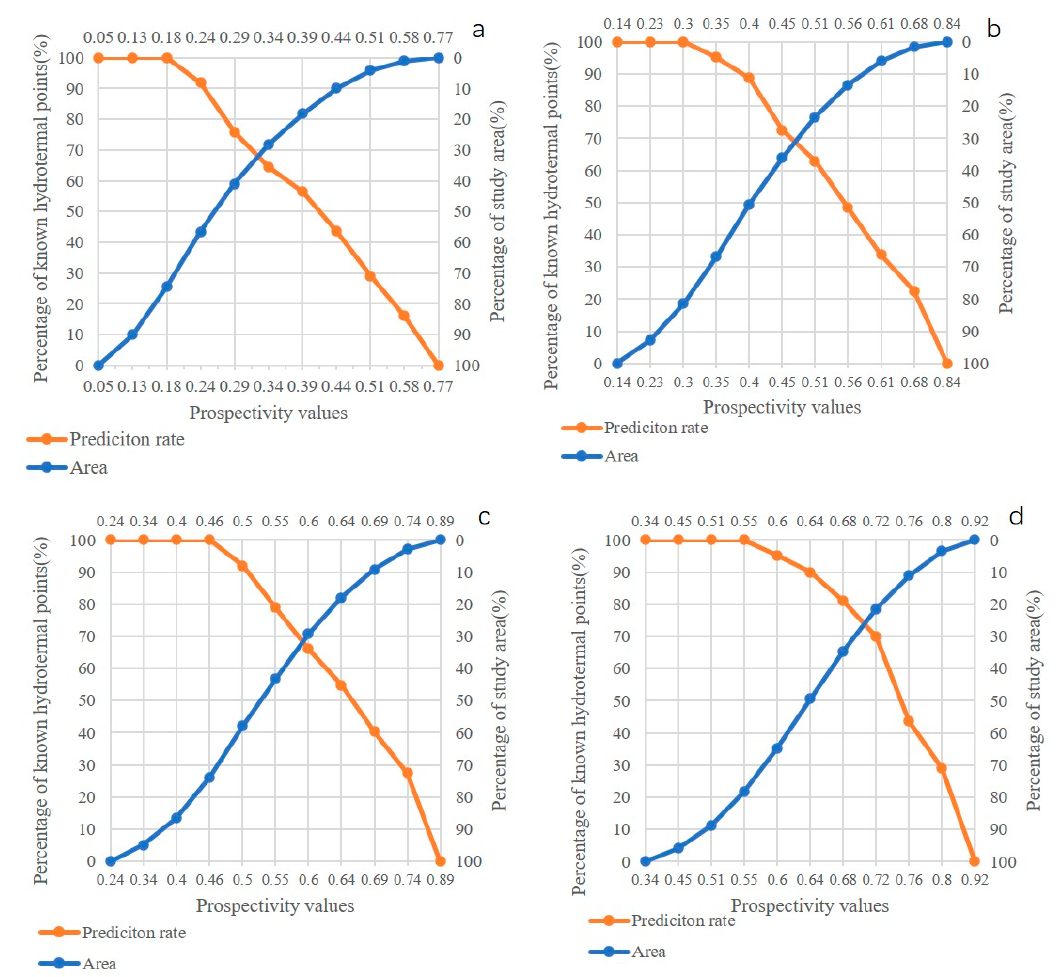
Figure 5. Comparison of di ff erent gamma values in fuzzy logic model. ( a ) γ = 0.85, ( b ) γ = 0.90, ( c ) γ = 0.93, ( d ) γ =